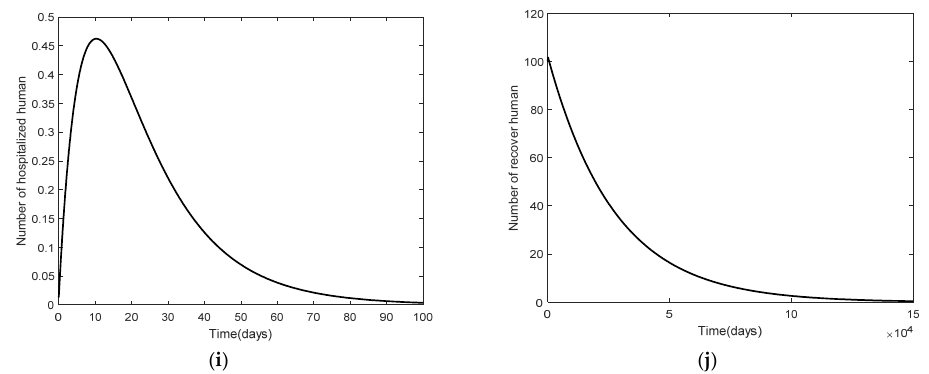
Figure 3. Graphs of the system of Equations (3)–(12) at the disease-free equilibrium point of 𝑆 (cid:3041) ,𝐸 (cid:3041) ,𝐼 (cid:3028)(cid:3041) ,𝐼 (cid:3046)(cid:3041) ,𝑆 (cid:3049) ,𝐸 (cid:3049) ,𝐼 (cid:3028)(cid:3049) ,𝐼 (cid:3046)(cid:3049) ,𝐻 (cid:3043) , and 𝑅 when 𝑅 (cid:2868) < 1 : ( a ) the number in the unvaccinated, susceptible population; ( b ) the number in the unvaccinated, exposed population; ( c ) the number in the unvaccinated, asymptomatic, infected population; ( d ) the number in the unvaccinated, symptomatic, infected population; ( e ) the number in the vaccinated, susceptible population; ( f ) the number in the vaccinated, exposed population; ( g ) the number in the vaccinated, asymptomatic, infected population; ( h ) the number in the vaccinated, symptomatic, infected population; ( i ) the number in the hospitalized population; and ( j ) the number in the recovered population.